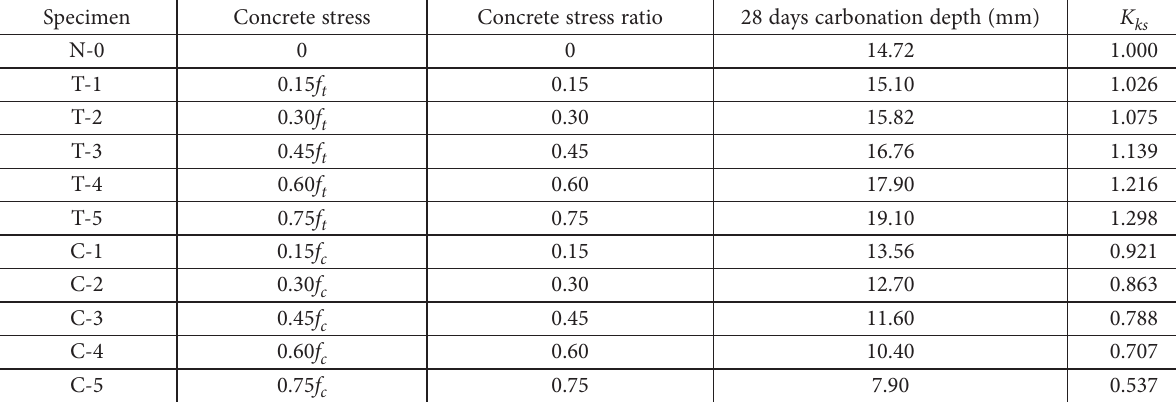
Table 3. Carbonation depths of specimens under different concrete stress conditions (data from Shi, 2008) Specimen